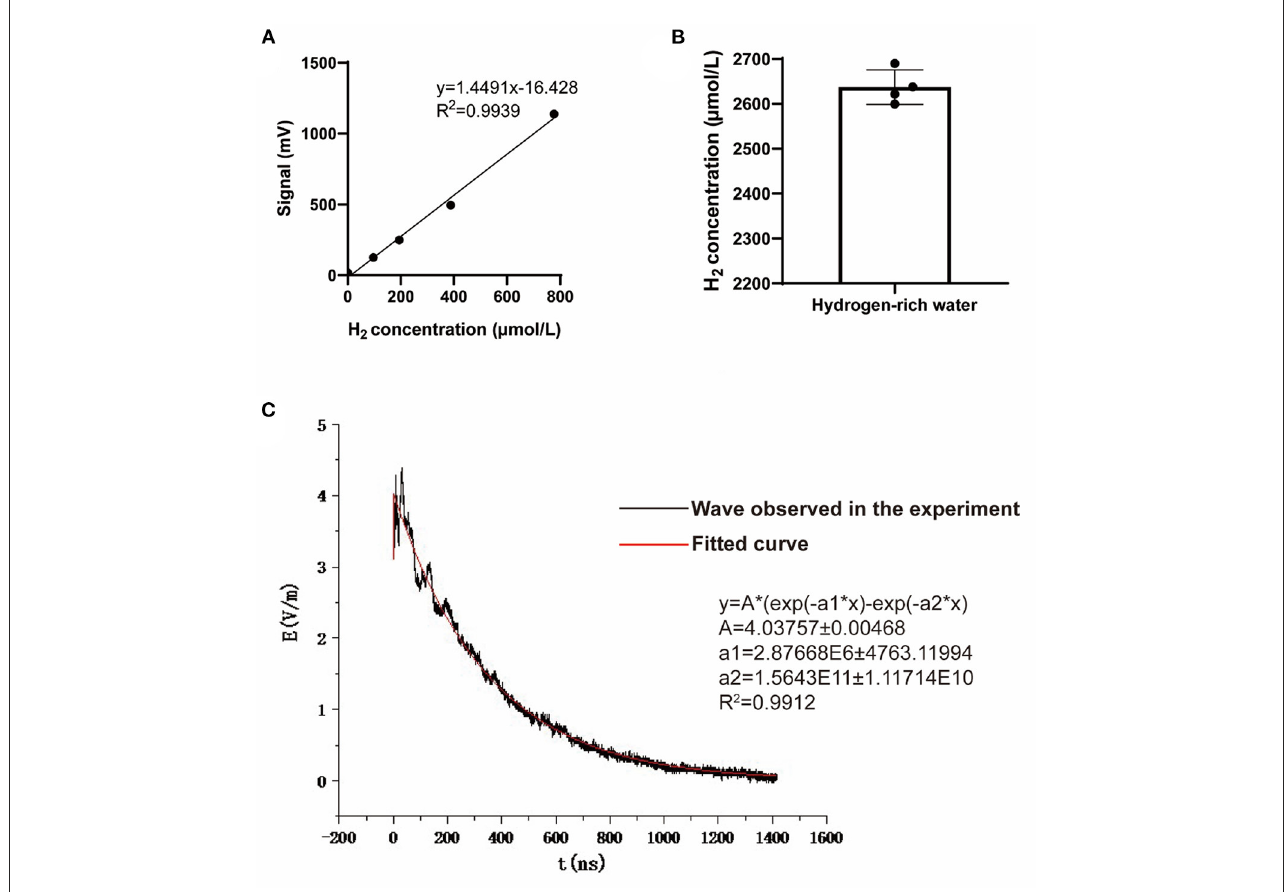
FIGURE2 Hydrogen concentration of the hydrogen-rich water and the waveform of the NEMP. (A) The standard curve used to detect hydrogen concentration in hydrogen-rich water. (B) The hydrogen concentration of the hydrogen-rich water used in this study. N = 4. (C) The waveform and paraments of the NEMP used in this